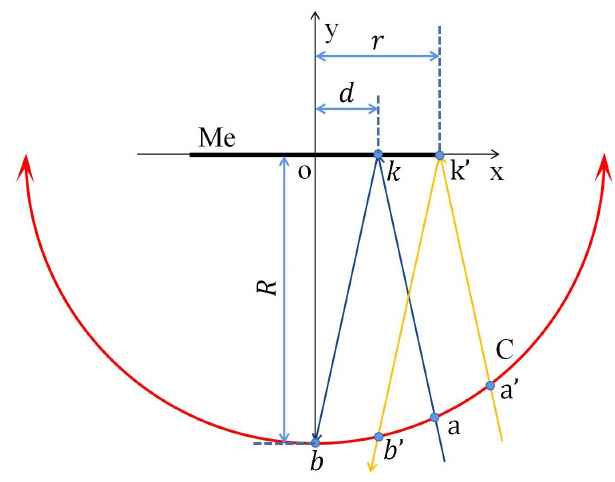
Figure 14. Diagram of robot position relationship.